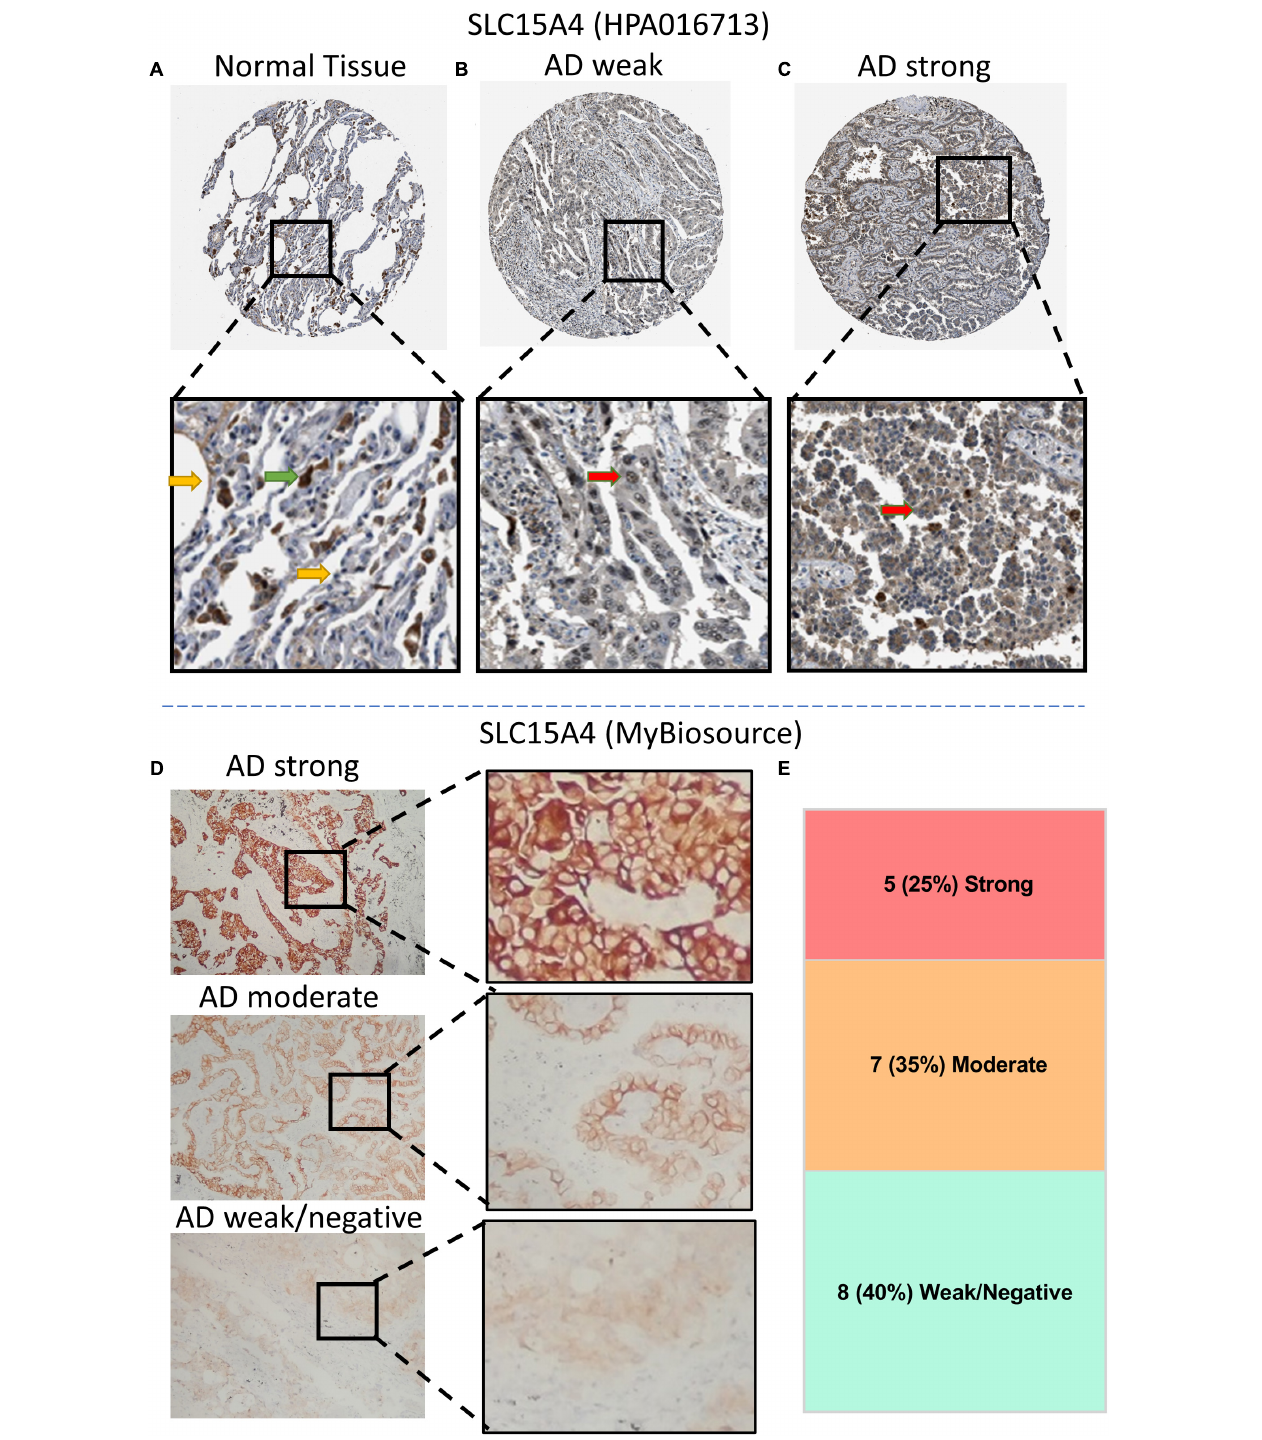
FIGURE 5 | Immunochemistry (IHC) of SLC15A4 in normal lung tissue and lung adenocarcinoma using HPA images (antibody HPA016713) and clinical patients (antibody MyBiosource). (A) Normal lung tissue. Positive staining was located mainly in macrophage cells. The green arrow indicates the macrophages, while the yellow arrow points at the normal pneumocytes. (B,C) Representative IHC with weak and strong staining in the cytoplasm of lung adenocarcinoma. Black rectangle indicates the zoomed zone in the picture. The red arrow indicates the lung cancer cells. (D) Differential expression of IHC intensity in lung adenocarcinoma. SLC15A4 shows a membrane and plasma staining pattern at a 1:100 primary antibody dilution. (E) The distribution of IHC intensity in 20 cases of lung adenocarcinoma staining by SLC15A4 antibody.